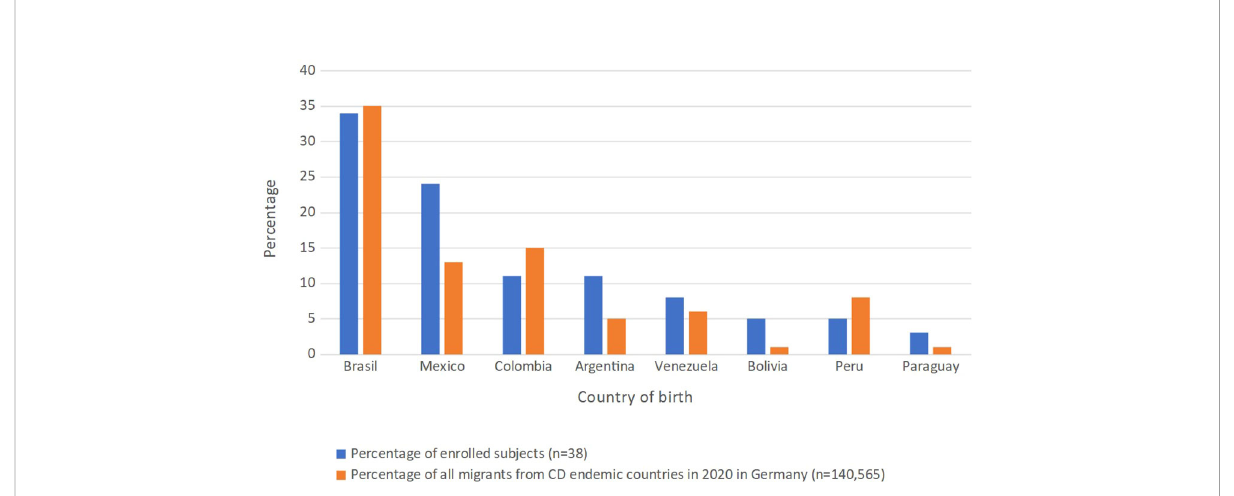
FIGURE 3 Comparison between the percentages of enrolled subjects and total registered immigrants from that country in Germany in